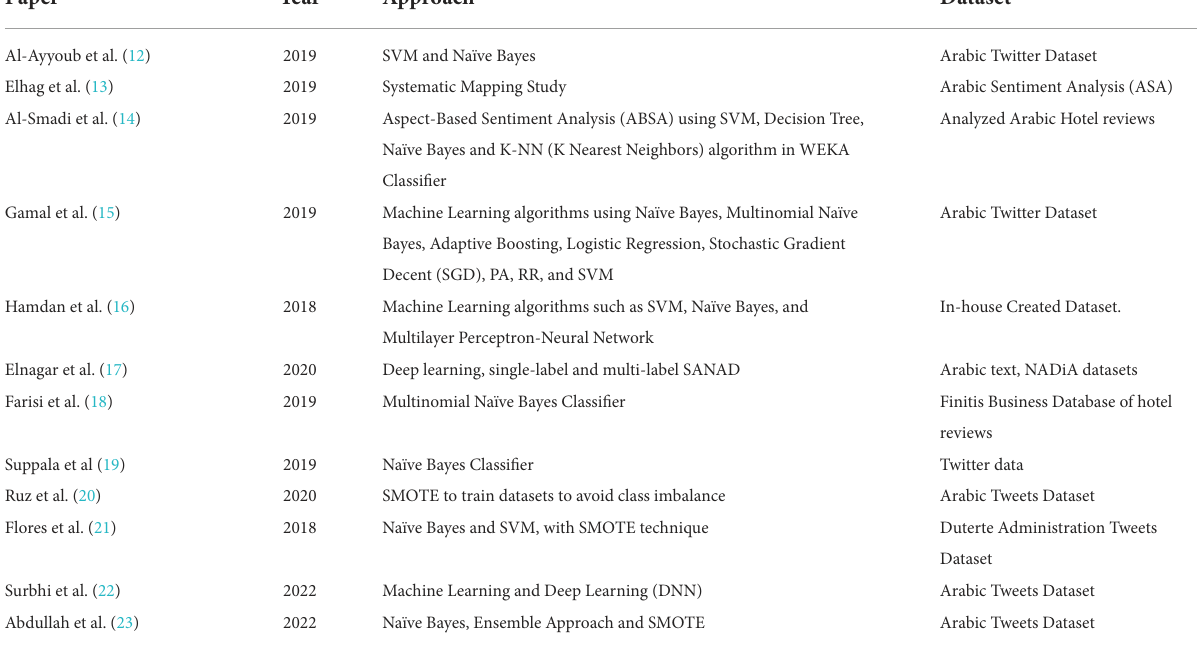
TABLE 1 State-of-the-art survey for sentiment analysis